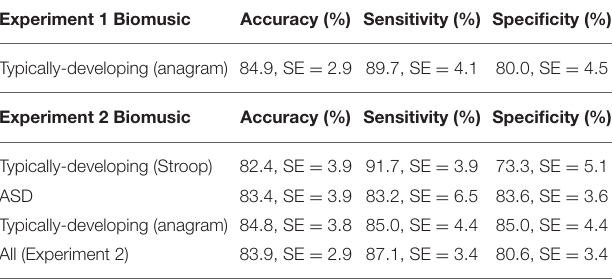
TABLE 3 | Biomusic performance (initial classification). Experiment 1 Biomusic